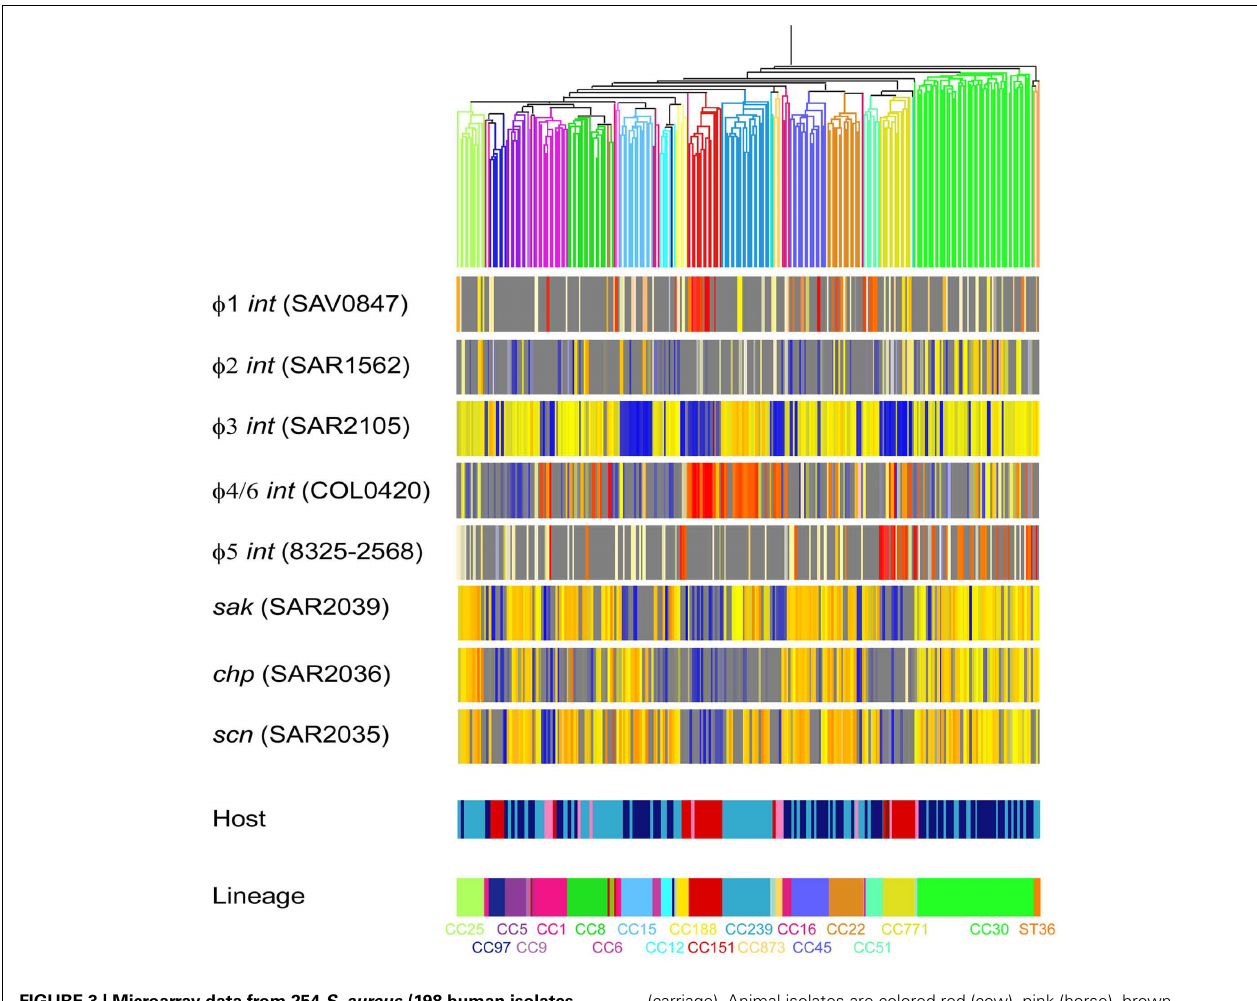
FIGURE 3 | Microarray data from 254 S. aureus (198 human isolates and 56 animal isolates). Isolates are clustered by Spearman correlation using 728 CV gene, as reported in Lindsay et al. (2006). Isolates of S. aureus are represented by vertical lines, and further information about the origin of each isolate is shown at the bottom of the figure (Host and lineage). Human isolates are colored light blue (invasive) and dark blue